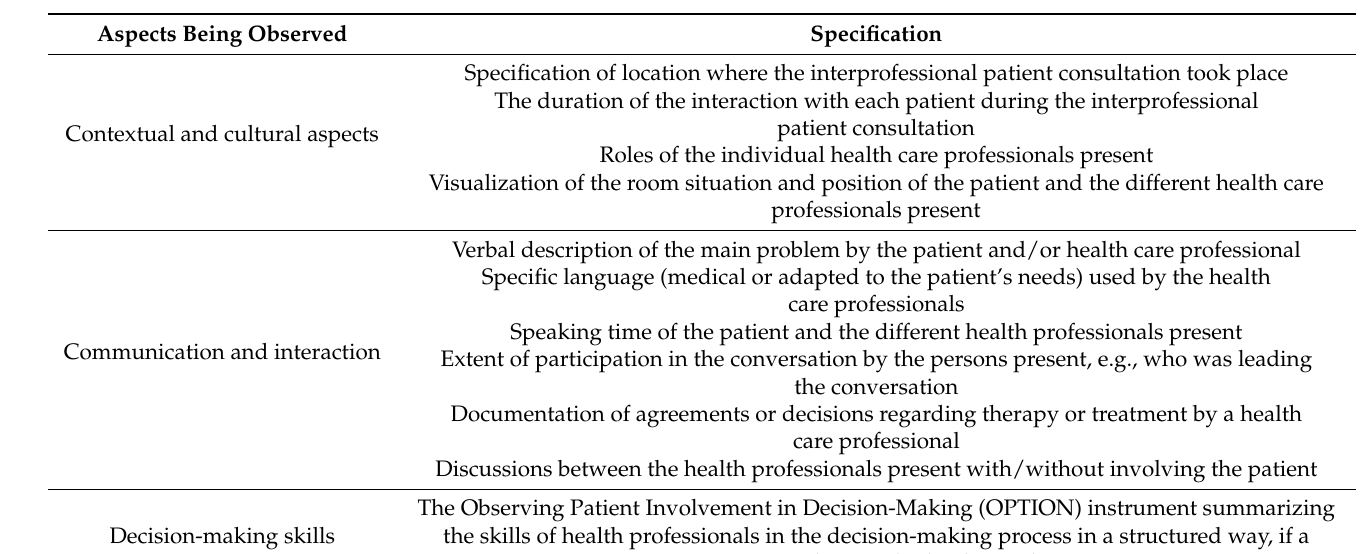
Table 1. Observation guide: Aspects being observed during interprofessional psychiatric